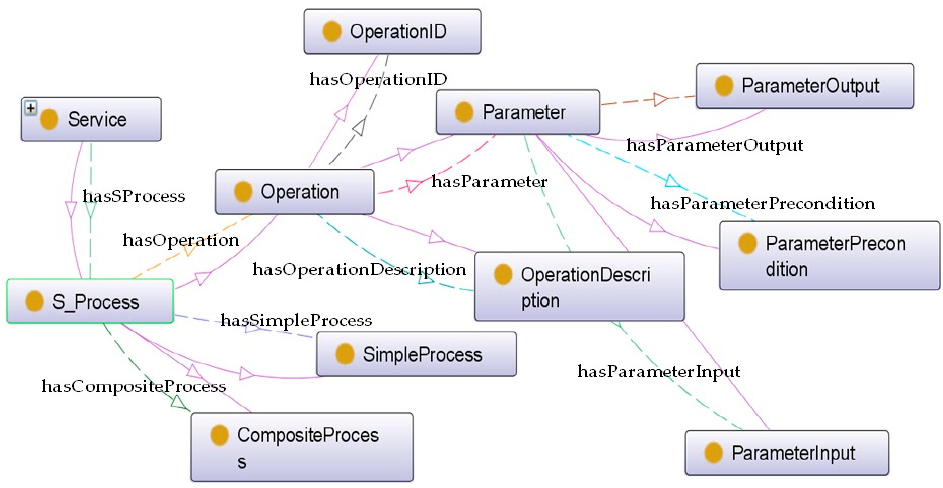
Figure 8. Internal structure of S_Process.